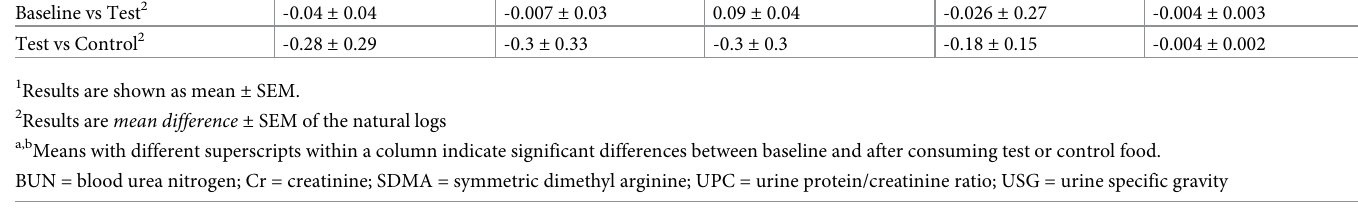
Table 3. Serum and urine kidney function biomarkers before (Baseline) and after feeding control and test food for eight weeks in Chronic Kidney Disease (CKD) cats. Cat